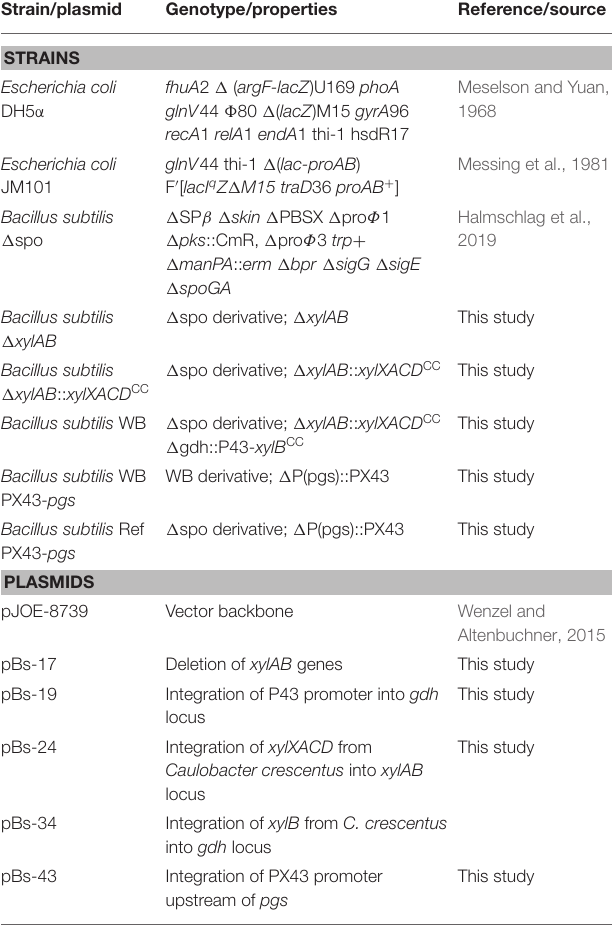
TABLE 1 | Strains and plasmids used in this study. Strain/plasmid Genotype/properties